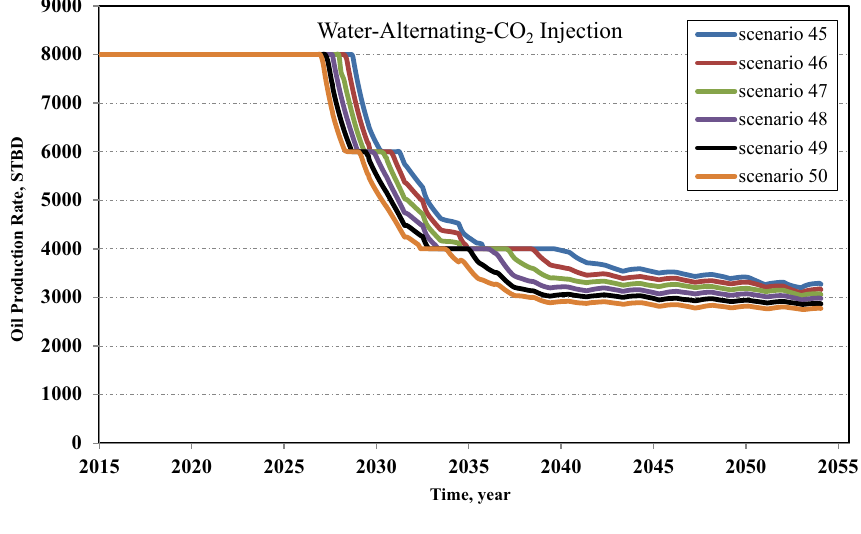
Fig. 19 Reservoir oil production rate for water-alternating-CO 2 injection into different reservoir